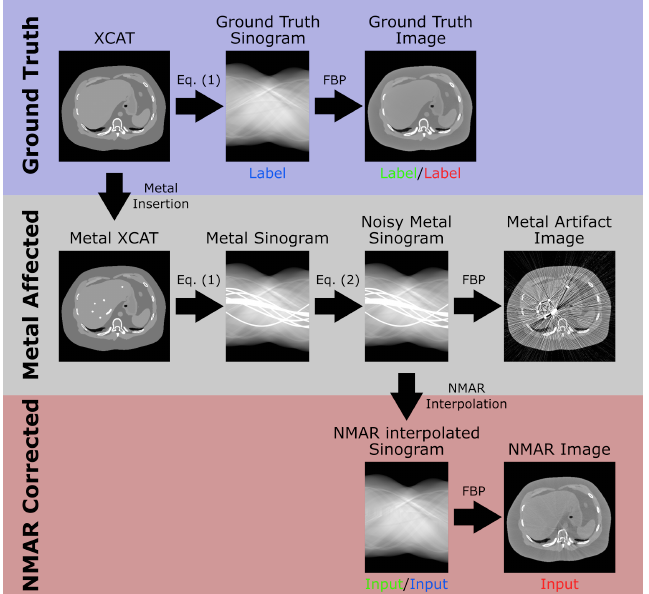
Figure 3. Generation of the metal training dataset. The input and labels for the three used deep learning networks are indicated by the colored words “Input” and “Label” beneath the corresponding images. The color coding corresponds to the colors used for the network architectures in Figure 1 (green: iCTU-Net, blue: U-Net Sino, and red: U-Net